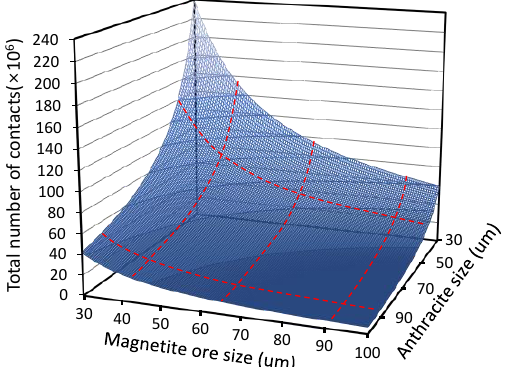
Figure 4. Change in the number of contacts between ore and coal with varying their sizes.